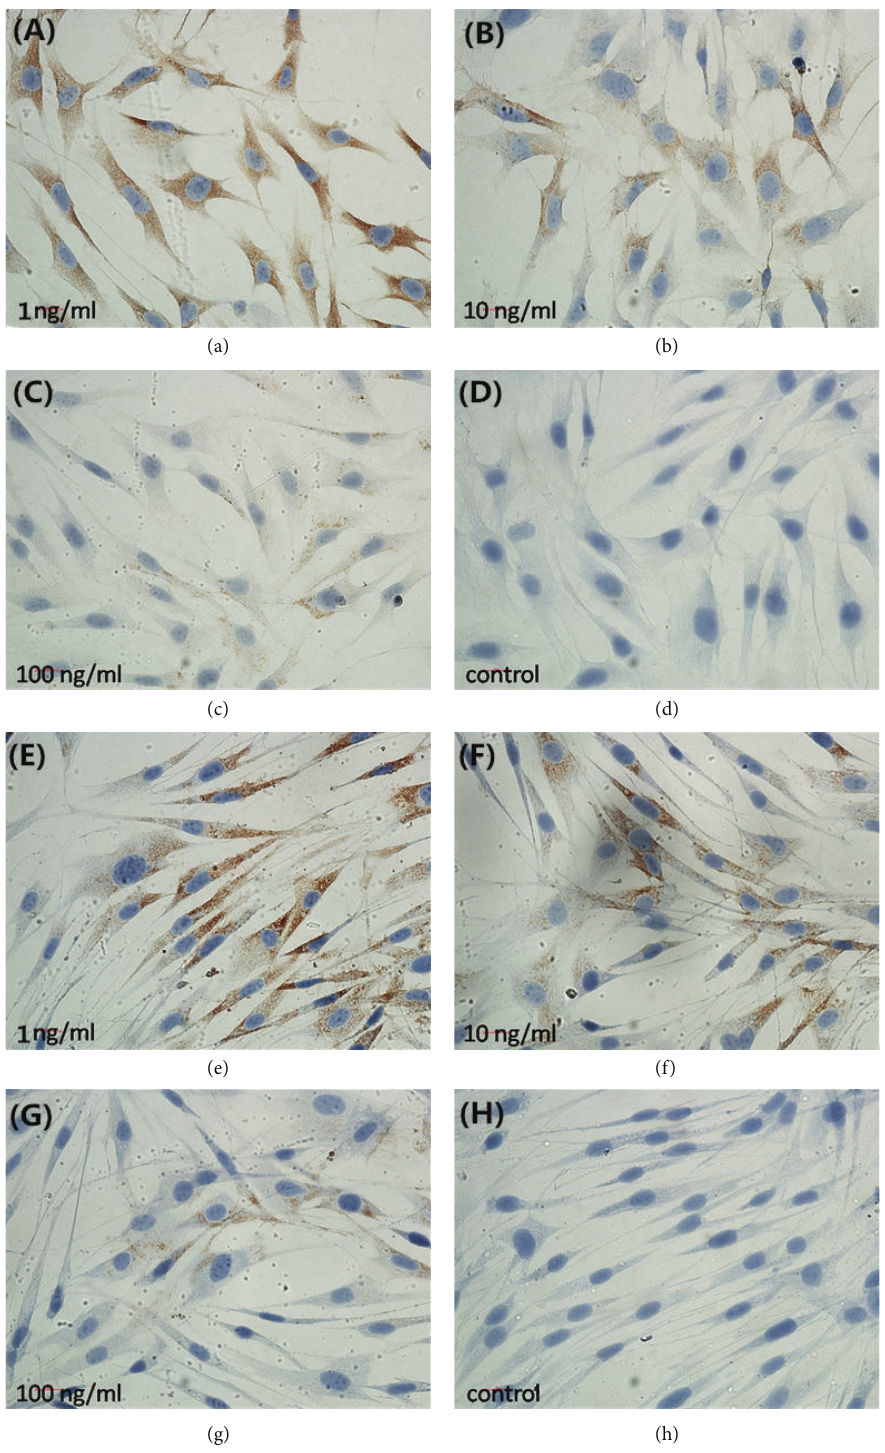
Figure 3: Immunohistochemical results of RANKL expression in OCCM-30 and MC3T3-E1 cells with TGF- 𝛽 1 treatment.